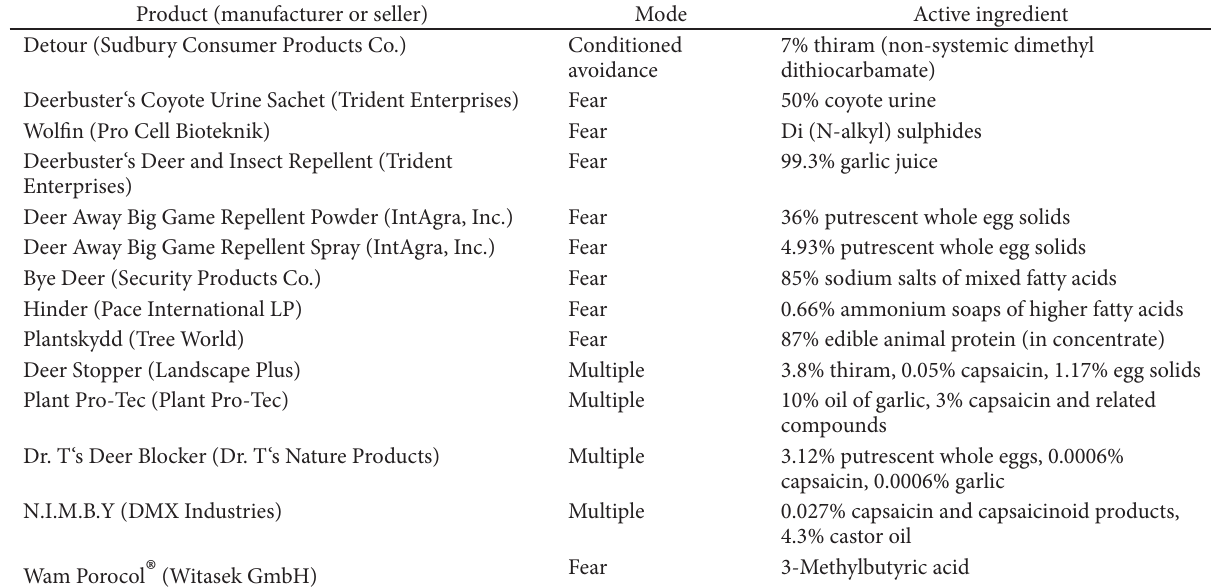
Table 3. Comparison of Wam Porocol® with other commercial repellents (based on Trent et al. 2001) Product (manufacturer or seller) Detour (Sudbury Consumer Products